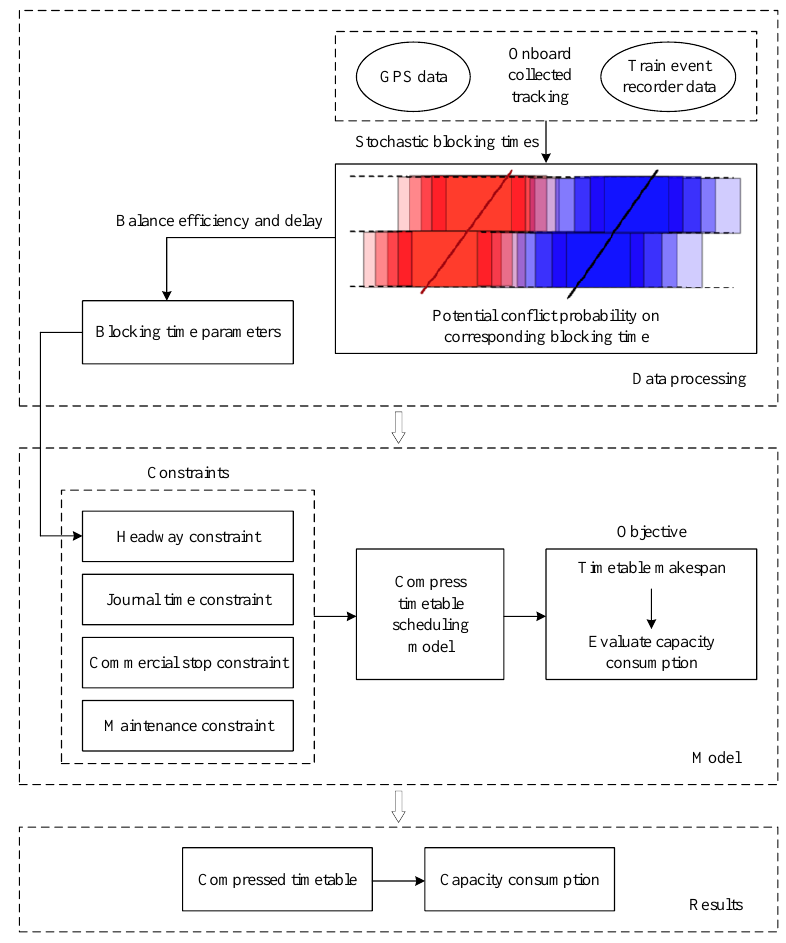
Figure 6. The flow chart of the solution.